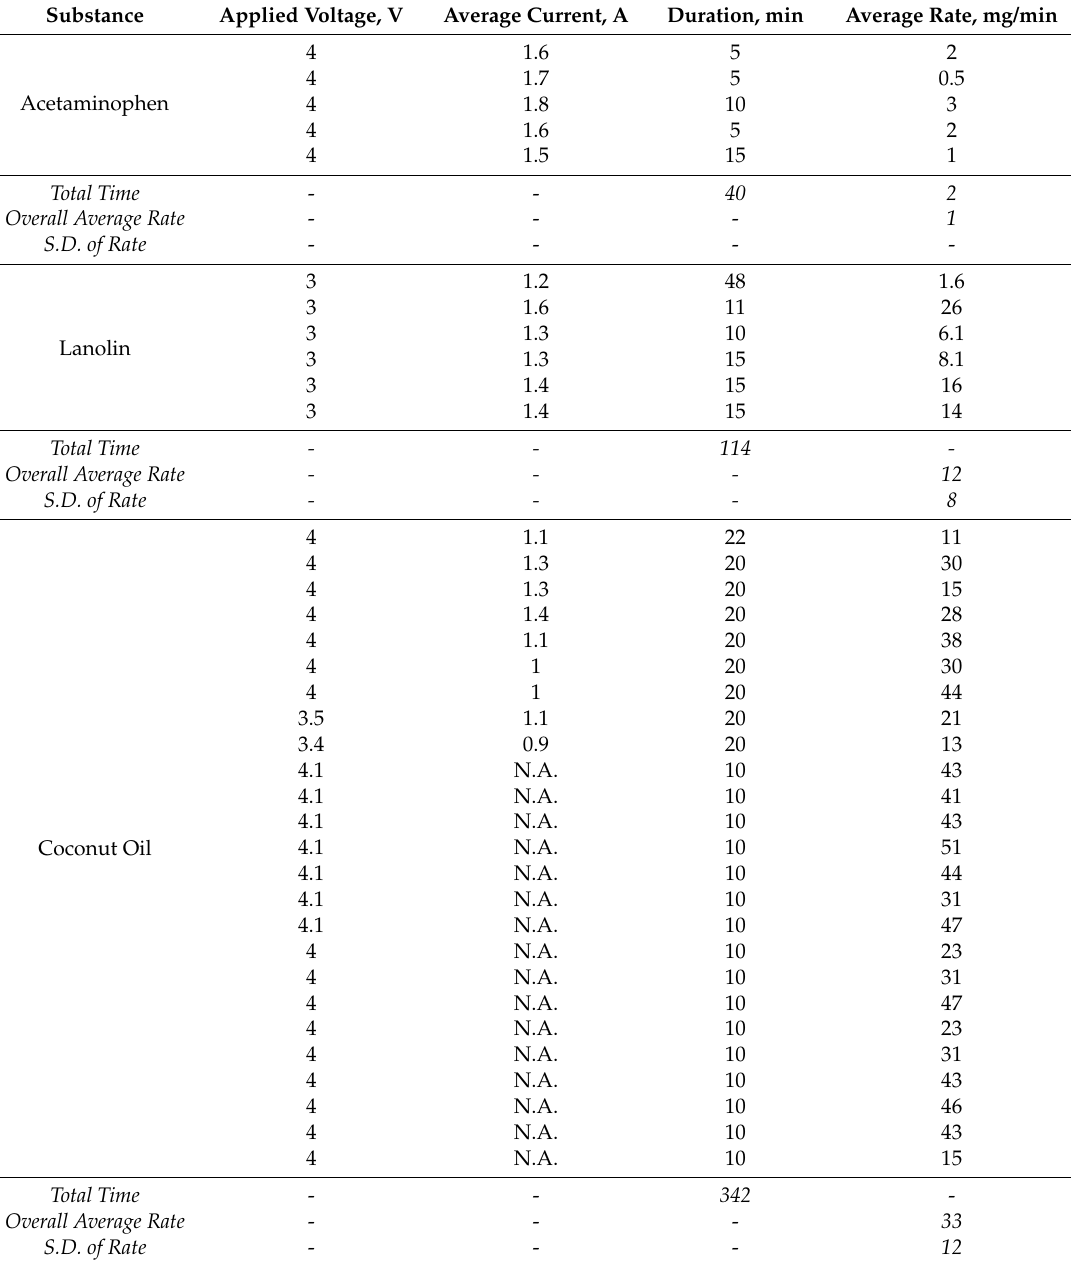
Table 3. Compilation of operating conditions and ereptiospiration rates for the fiber bundle/coil system for acetaminophen, lanolin, and coconut